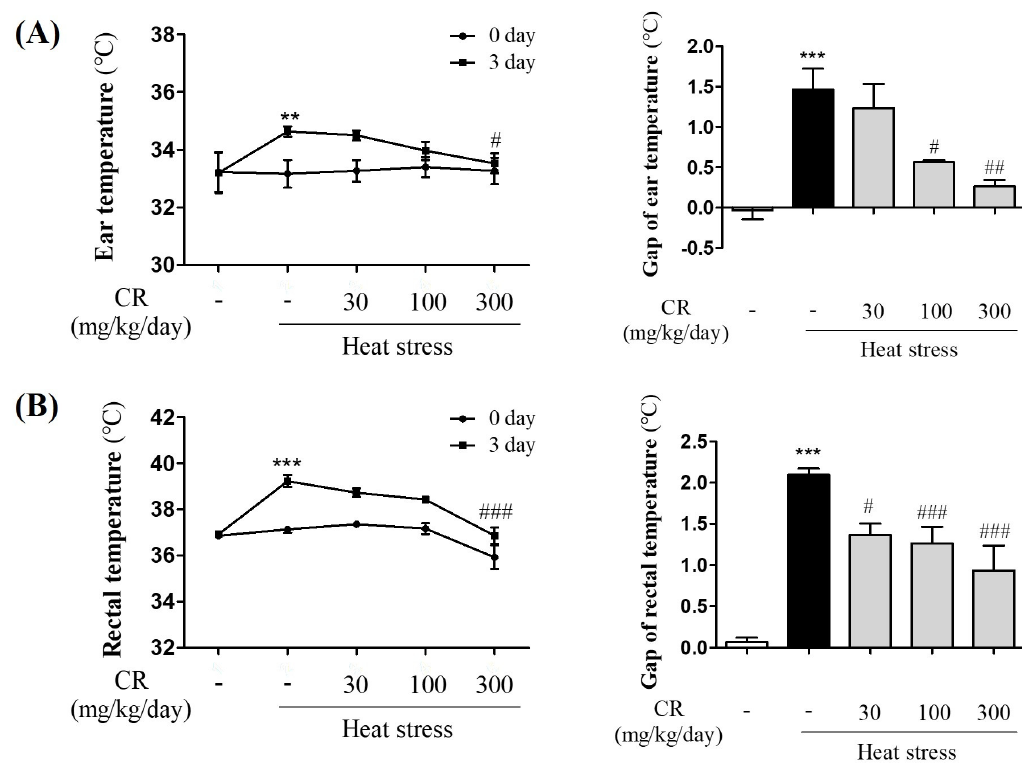
Figure 1. Inhibitory effects of Coptidis Rhizoma (CR) on heat exposure ‐ induced hyperthermia. The white, black and gray bars indicate the control group, the heat ‐ stressed vehicle ‐ treated group and heat ‐ stressed CR ‐ treated groups, respectively. ( A ) Treatment with CR significantly lowered the heat exposure ‐ induced elevation of ear temperature in a dose ‐ dependent manner. ( B ) The temperatures of the CR ‐ treated group were significantly lower than that of the heat ‐ stressed vehicle ‐ treated group in dose ‐ dependent manner. Values are expressed as means ± SEM. ** p < 0.01 and *** p < 0.001 as compared with the control group. # p < 0.05, ## p < 0.01 and ### p < 0.001 as compared with the heat ‐ stressed vehicle ‐ treated group.